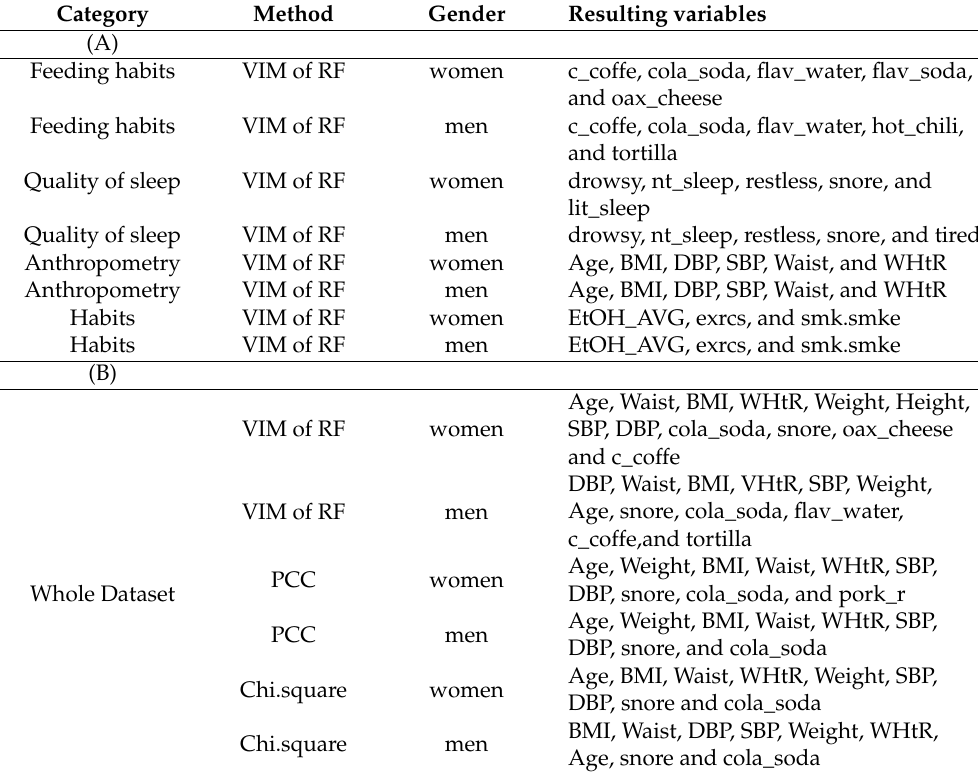
Table 3. (A) Resulting variables by category. (B) Resulting variables in whole dataset by